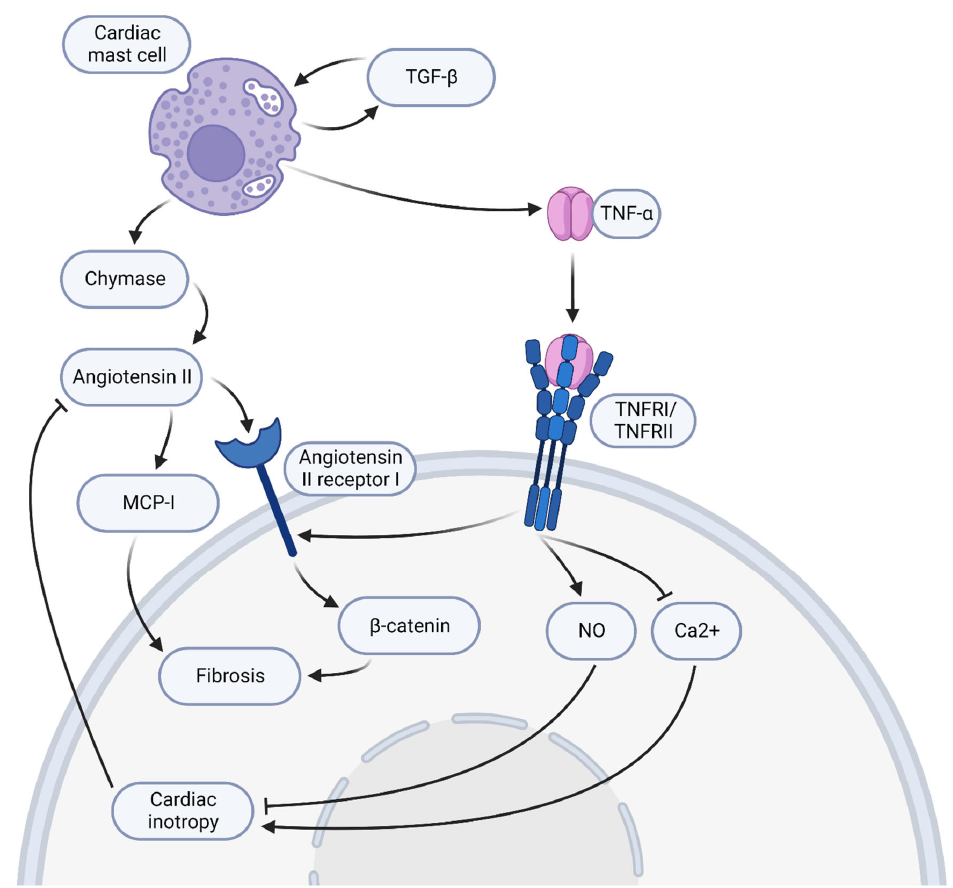
Figure 5. TNF ‐α pathways in cardiac fibrosis. Tumor necrosis factor alpha (TNF ‐α ) binds to tumor necrosis factor receptors I and II (TNFRI and TNFR II) which can initiate several pathways that contribute to cardiac tissue fibrosis. TNFRI increases the expression of angiotensin II receptor I, which, when bound to angiotensin II, upregulates the β‐ catenin pathway to fibrosis. TNFRI and TNFRII upregulate nitric oxide (NO) production while decreasing Ca 2+ fluxes. NO decreases cardiac inotropy while the inhibition of Ca 2+ fluxes inhibits positive cardiac inotropy, collectively causing decreased cardiac inotropy and upregulating angiotensin II activity. Angiotensin II promotes mac ‐ rophage chemotactic protein I (MCP ‐ 1) production to increase fibrosis in addition to the β‐ catenin pathway. Transforming growth factor beta (TGF ‐β ) interacts with these pathways through the re ‐ cruitment of cardiac mast cells. Mast cell degranulation releases additional TFG ‐β as well as TNF ‐α and chymase. Chymase converts angiotensin I to angiotensin II, increasing those associated path ‐ ways. Figure created with BioRender. 5. Specific Considerations for Congenital Heart Defect Patients Congenital heart defects are estimated to affect as many as 1% of live births in the US [208]. As surgical procedures have advanced, the proportion of those born with CHD who survive into adulthood has increased dramatically. As more of these patients live into adulthood with surgical correction, they are found to have decreased cardiac function compared to adults not born with these defects. Similar cardiac function as those with heart failure have been observed [6]. Previous studies found nearly 30% of hospitalized CHD patients could be attributed to heart failure symptoms. This increased risk for de ‐ velopment of heart failure is likely from increased fibrosis [6]. CHD patients demonstrate